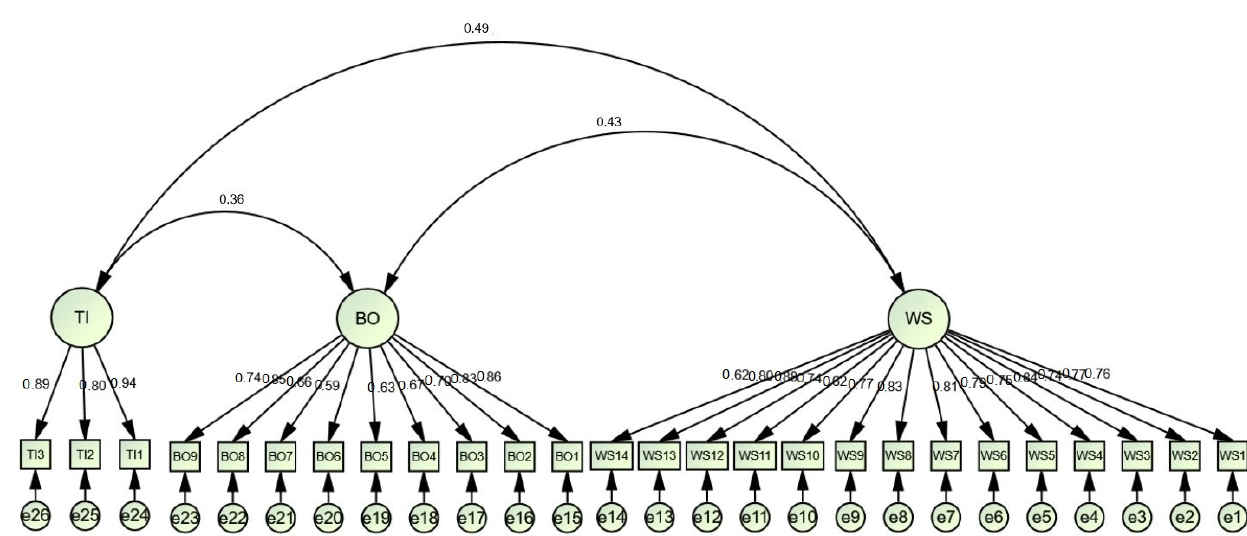
Figure 2. Confirmatory Factor Analysis.